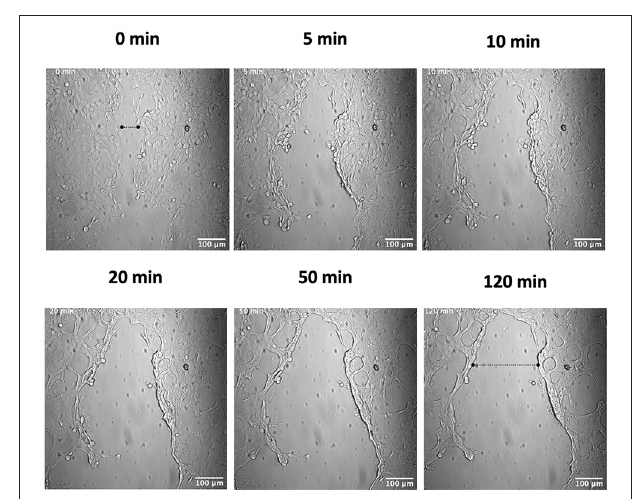
FIGURE 2 | Plasmin causes a rapid wound retraction of keratinocytes. Scratch wounds were produced as in Figure 1 , and cells were then incubated with 7 µ g/ml of hPm and analyzed by live imaging. Images were obtained every 2.5min for 2h for the duration of the imaging experiment. Time-lapsed images of the experiment are shown here (see Supplementary Video 2 ). Dashed lines show the approximate width of the wound at the start and end